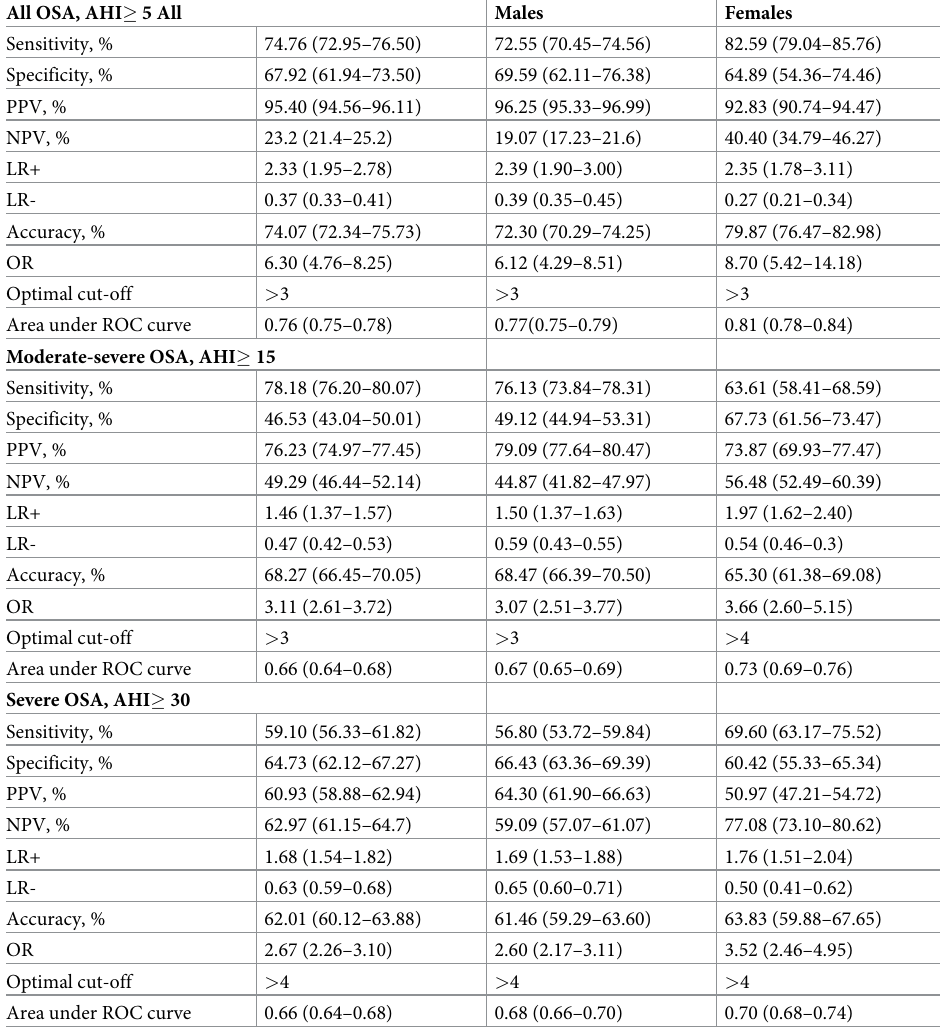
Table 3. Predictive parameters for SANReSP